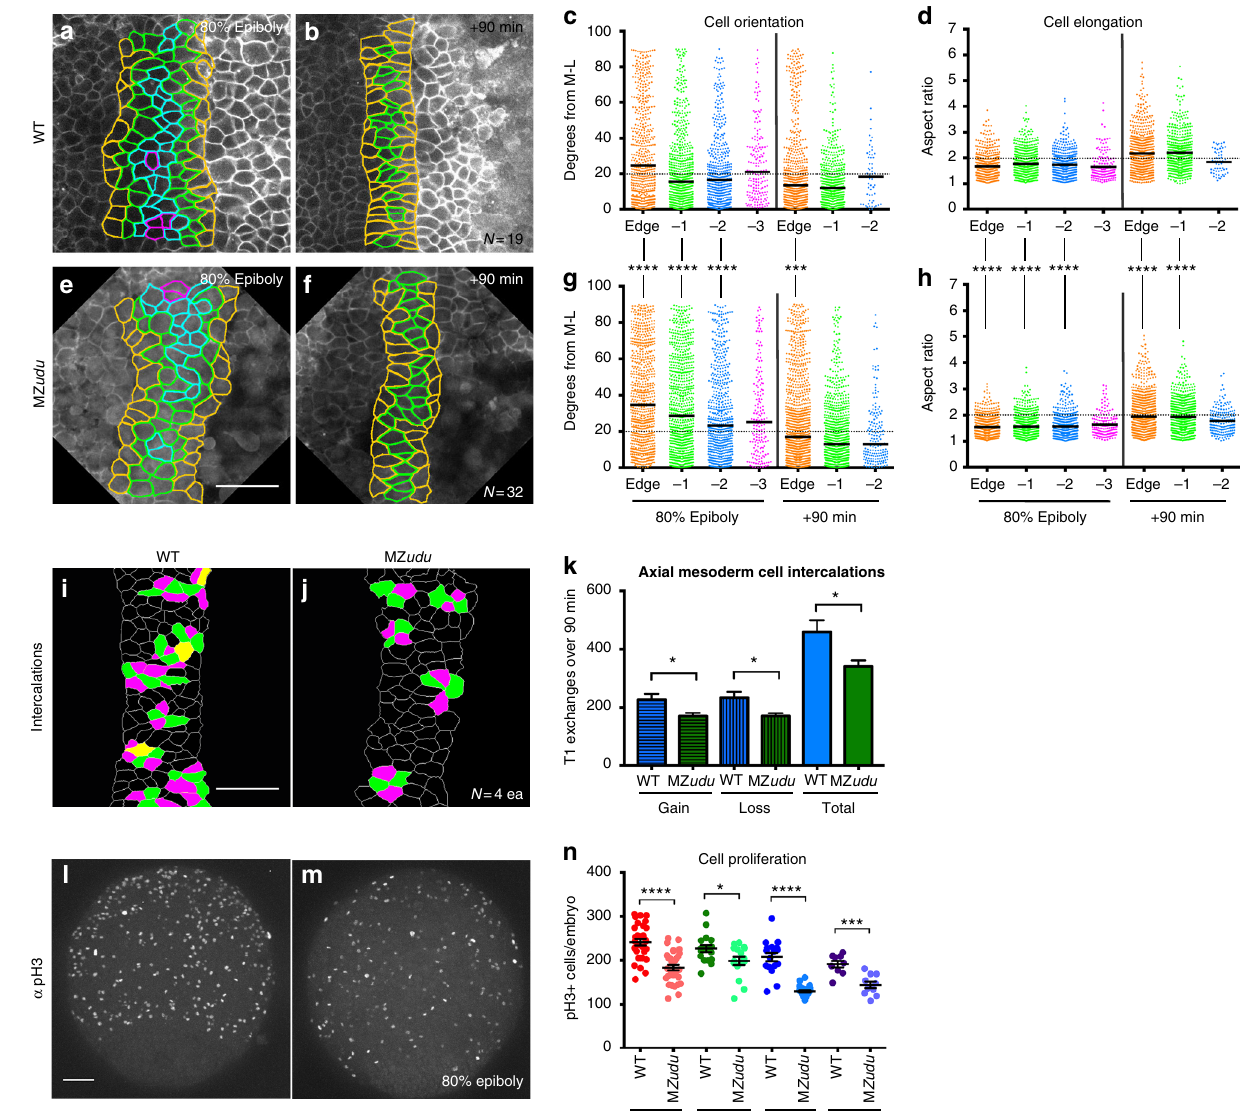
Fig. 3 Mediolateral cell polarity and cell intercalations are reduced in the axial mesoderm of MZ udu − / − gastrulae. a – b , e – f Still images from live time-lapse confocal movies of the axial mesoderm in WT ( a , b ) and MZ udu − / − ( e , f ) gastrulae at the time points indicated. Cell outlines are colored according to a cell ’ s position with respect to the notochord boundary. c , g Quanti fi cation of axial mesoderm cell orientation at 80% epiboly (left side) and + 90 min (right side) time points. Each dot represents the orientation of the major axis of a single cell with respect to the embryonic ML axis and is colored according to that cell ’ s position with respect to the notochord boundary (as in images to the left). Bars indicate median values. Asterisks indicate signi fi cant differences between WT and MZ udu − / − (Kolmogorov – Smirnov test, *** p < 0.001, **** p < 0.0001). d , h Quanti fi cation of axial mesoderm cell elongation at 80% epiboly (left side) and + 90 min (right side) time points. Each dot represents the aspect ratio of a single cell and is color-coded as in c . Bars indicate mean values. Asterisks indicate signi fi cant differences between WT and MZ udu − / − (Mann – Whitney test, **** p < 0.0001). i – j Cell intercalations detected in the axial mesoderm of WT ( i ) and MZ udu − / − gastrulae ( j ). Cells gaining contacts with neighbors are green, cells losing contacts are magenta, and cells that both gain and lose contacts are yellow. k Quanti fi cation of cell intercalation events (T1 exchanges) in WT (blue bars) and MZ udu − / − gastrulae (green bars) over 90 min. N indicates the number of embryos analyzed. Bars are means with SEM ( T -test, * p < 0.05). l – m 200 μ m confocal Z projections of immuno fl uorescent staining for phosphorylated Histone H3 (pH3) in WT ( l ) and MZ udu − / − gastrulae ( m ) at 80% epiboly. Images are representative of eight independent trials. n Quanti fi cation of pH3 + cells/embryo at the stages indicated. Each dot represents a single embryo, dark lines are means with SEM ( T -test, * p < 0.05, *** p < 0.001, **** p < 0.0001). Scale bars are 50 μ m. Anterior/animal pole is up in all